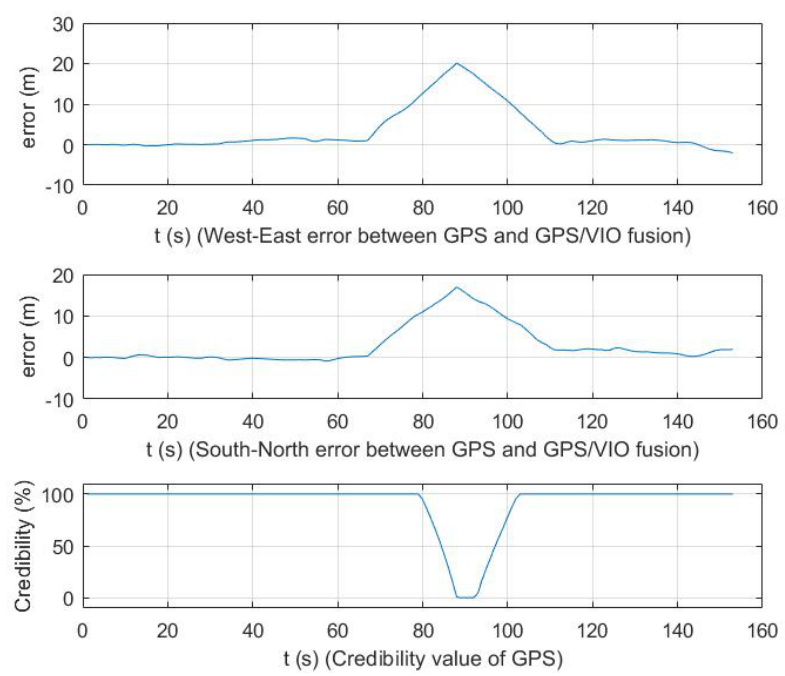
Figure 14. GPS error and